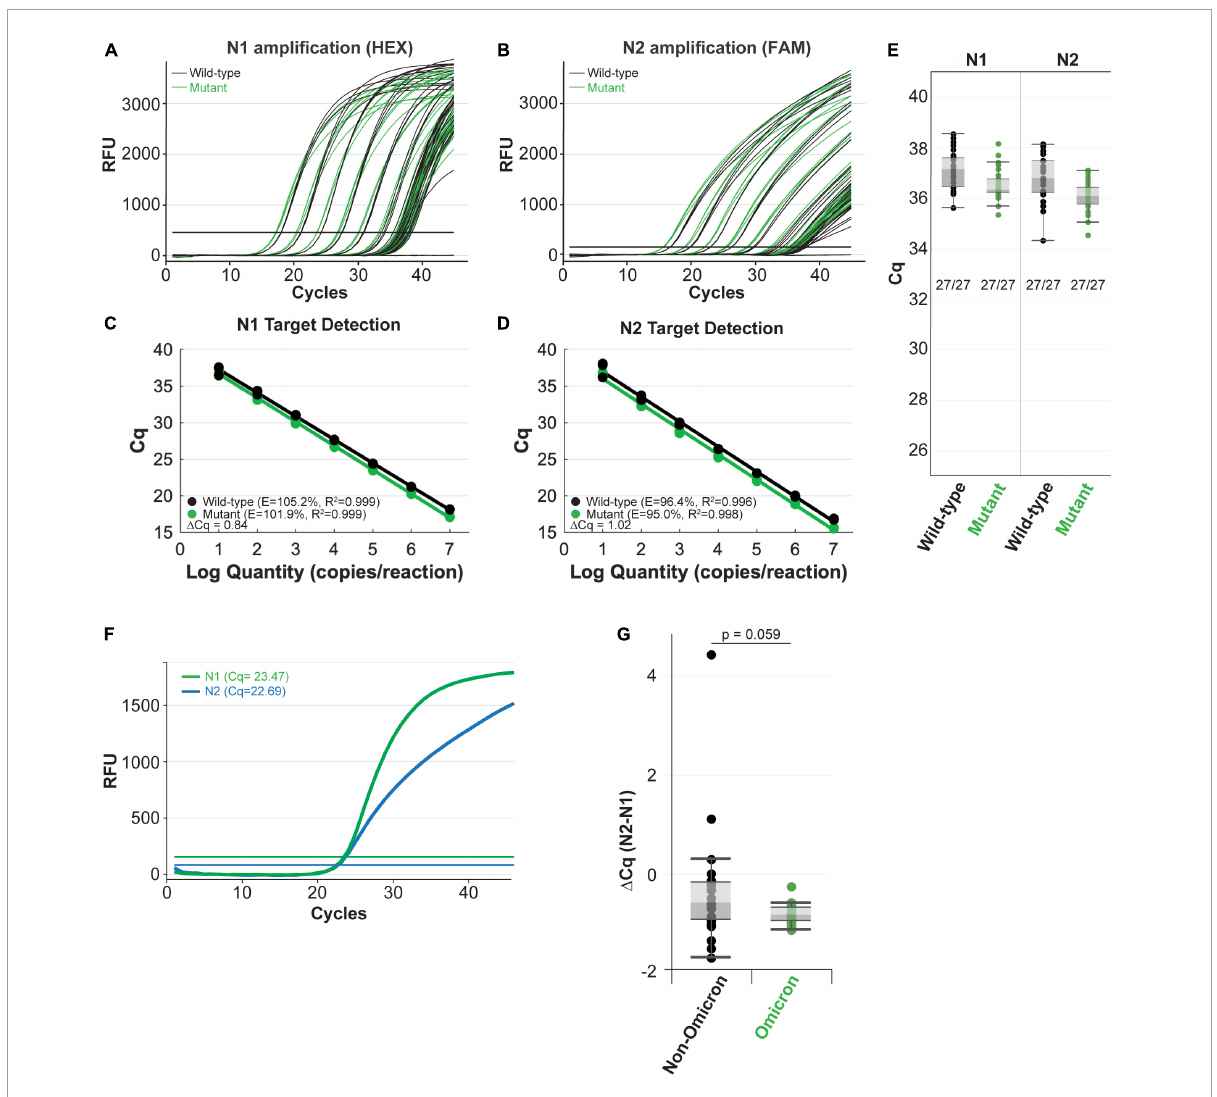
FIGURE4 The NEB SARS-CoV-2 multiplex assay efficiently detects N gene IVT RNA carrying the Omicron mutation (A–E) and clinical Omicron RNA (F,G) with the CDC 2019-nCoV_N1 primer-probe set. Amplification efficiency in panels (A–D) was evaluated in triplicate over a 7-log range (10 7 -10 copies/reaction) of synthetic N gene RNA for wild-type (black) vs. the Omicron variant (green). Detection sensitivity (E) was evaluated with 10 copies of RNA per reaction with 27 replicates per condition. All reactions tested with 10 copies of input RNA were detected by qPCR. Both the N1 (green) and N2 (blue) targets were efficiently amplified from clinical Omicron RNA samples using the NEB Luna SARS-CoV-2 RT-qPCR Multiplex Assay Kit, which includes the CDC 2019-nCoV_N1 and 2019-nCoV_N2 primer-probe sets (F,G) . Cq values for each clinical sample shown (G) are included in Supplementary Table 2